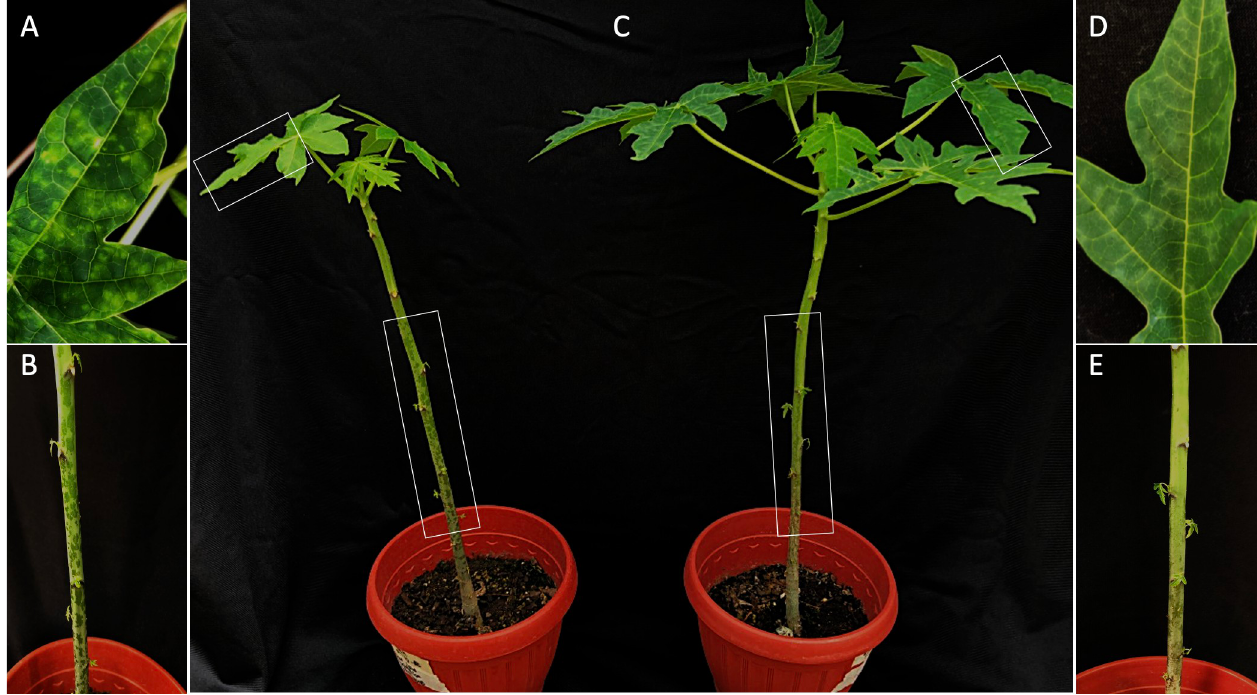
Fig 1. Symptom expression in papaya plants infected with papaya ringspot virus (PRSV). Severe leaf vein clearing (A) and oily streaks on the stem (B) induced by the severe isolate of PRSV (PRSV-sev). C) Overall growth comparison between plants infected with PRSV-sev (left) and the mild isolate (PRSV- mild) (right). Mild powder-like patches radiating from leaf secondary veins (D) and absence of oily streaks (E) induced by PRSV-mild. Specific symptoms on leaves and stems are shown by white boxes.